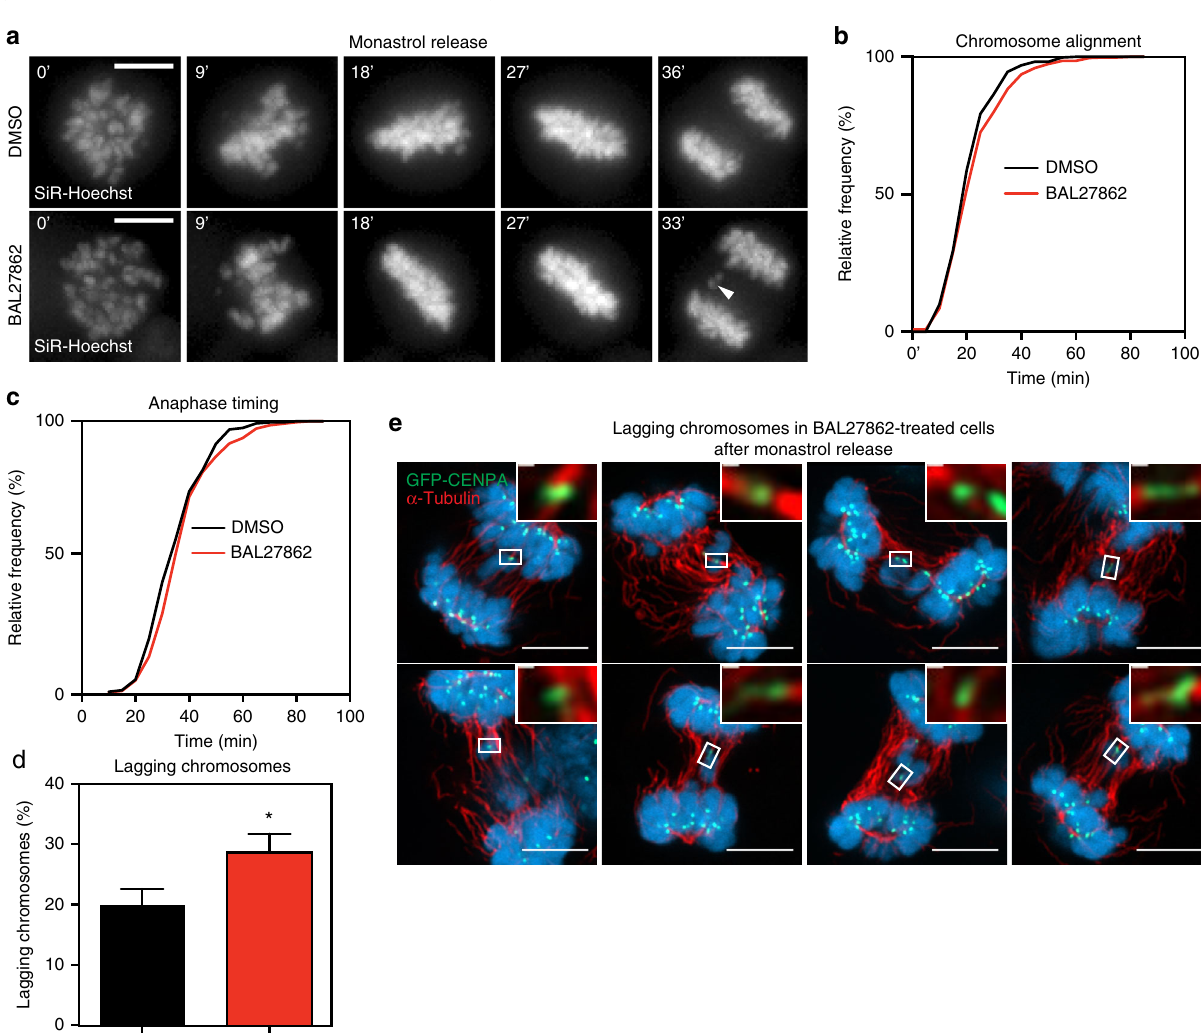
Fig. 6 Complete KT – MT occupancy prevents lagging chromosomes. a Time lapse images of hTert-RPE1 GFP-CENPA cells released from a monastrol- treatment ( T = 0 min). SiR-Hoechst was used to visualize chromosomes; a lagging chromosome is marked with white arrowhead. Scale bar = 5 μ m. b , c Cumulative frequency graph of chromosome alignment ( b ) and anaphase time ( c ) in hTert-RPE1 GFP-CENPA cells treated with DMSO (black) or 12 nM BAL27862 (red) in a monastrol-release assay. T = 0 at monastrol release. N = 9, n = 530 – 549 cells. d Percentage of cells treated with DMSO or 12 nM BAL27862 with lagging chromosomes in anaphase after a monastrol release, * DMSO vs BAL27862 p = 0.0135 in ratio paired two-tailed t -test, N = 9, n = 459 – 469 cells, error bars show s.e.m. e Immuno fl uorescence images of 10 hTert-RPE1 GFP-CENPA cells from a single monastrol release experiment. Cells were treated in parallel with DMSO or 12 nM BAL27862 and 100 μ M monastrol (4 h), released from monastrol for 60 min, fi xed and stained with α -tubulin antibodies (red). Scale bars = 5 μ m. Inserts show single, merotelically attached KTs. Scale bars = 250